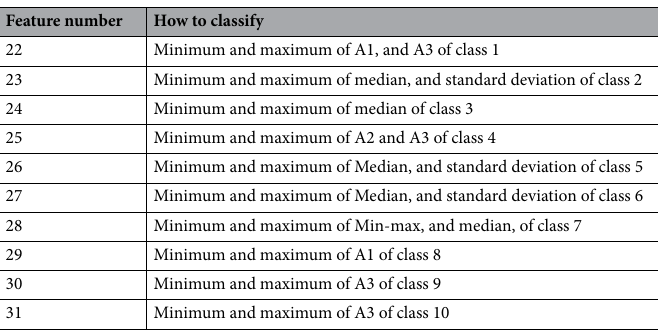
Table 2. The nested features produced to improve the model accuracy.